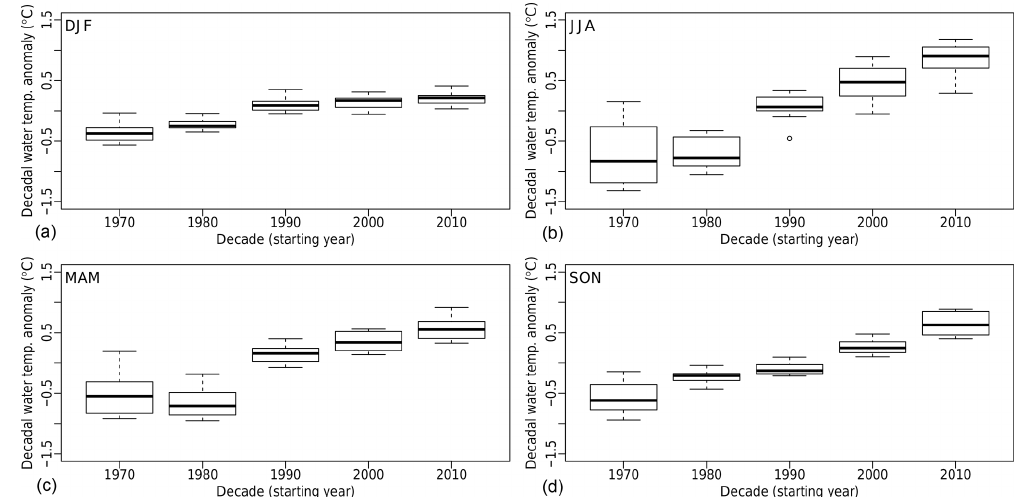
Figure 8. Water temperature seasonal anomalies for the 14 catchments where data are available since 1970 (see Table 1). Anomalies with respect to the 1970–2018 period. Seasons are defined as follows: winter is December–January–February (DJF, a ), spring is March–April–May (MAM, b ), summer is June–July–August (JJA, c ), and autumn is September–October–November (SON, d ).